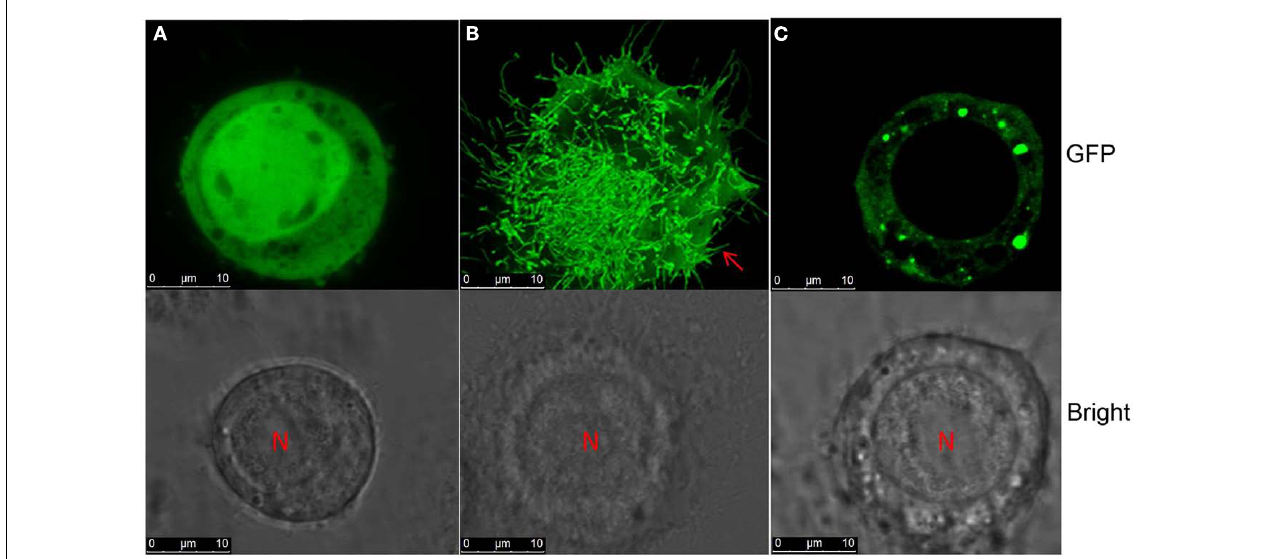
FIGURE 11 |Tubule formation in Sf-9 cells. S. frugiperda 9 cells were transinfected with recombinant baculovirus AcNPV/GFP (A) , AcNPV/NSm-GFP (B) , or AcNPV/NSvc4-GFP (C) . Images were taken at 72h post